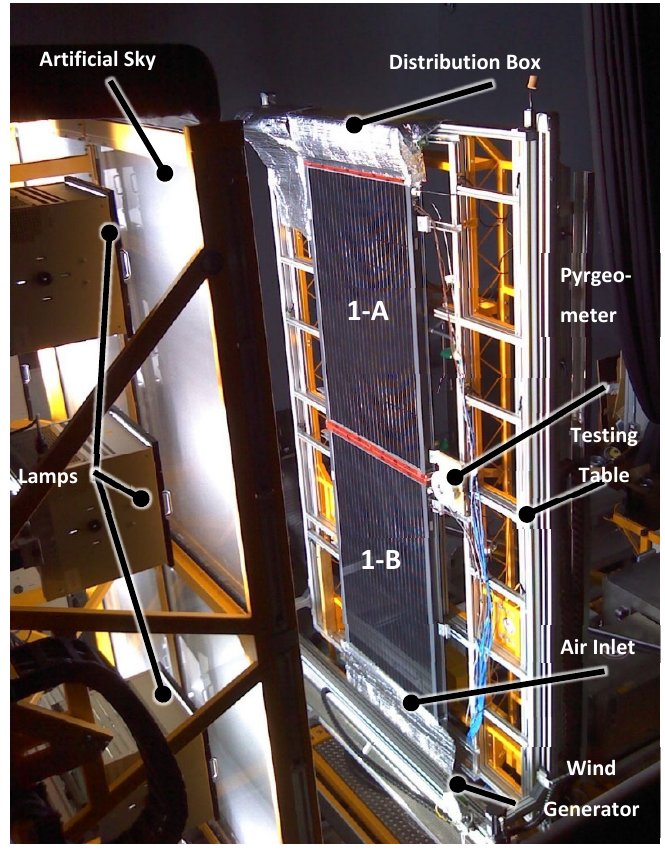
Figure 3. Components of the SSEC.